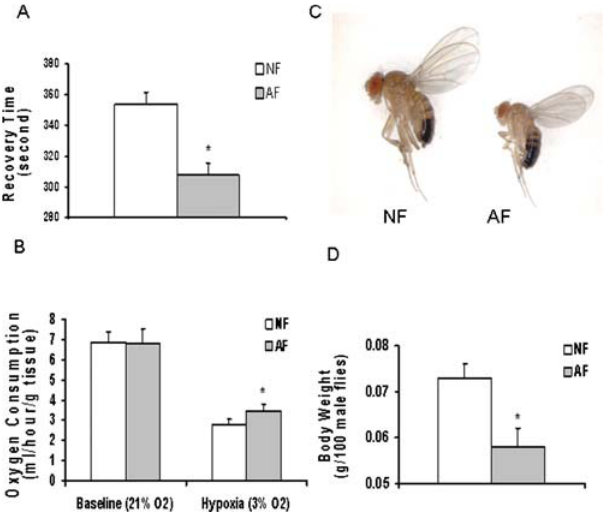
Figure 1. Phenotypic changes following long term hypoxia selection. (A): Shortened recovery time of AF flies from anoxic stupor. Groups of 10 to 15 NF or AF flies were subjected to pure N 2 for 5 min (anoxia) at room temperature. Recovery time of each fly from the time of anoxic stupor to that of arousal following reintroduction of room air was recorded. A significantly shortened recovery time was found in AF flies ( p , 0.01; NF: n=166, AF: n=114). (B): Increased O 2 consumption rate of AF flies in hypoxic condition. O 2 consumption rate was measured in a sealed testing jar at room temperature under normoxia (21% O 2 , Baseline) and hypoxia (3% O 2 , Hypoxia), respectively. Groups of 600 to 800 NF or AF flies were used in each test. Although both AF and NF decreased their O 2 consumption when switched to hypoxic condition, AF flies reduced less than NF ( p , 0.01, n=5). (C and D): Decreased body size and weight in AF flies. AF flies had decreased body weight and size. Body weight of a group of 100 NF or AF male flies were measured at 16 th and 17 th generation (n=6) following hypoxia selection. A significant decrease at body weight was found in AF flies (lower panel, p , 0.01). Data were presented as mean 6 SEM, and the statistical significance was analyzed by student’s t -test.